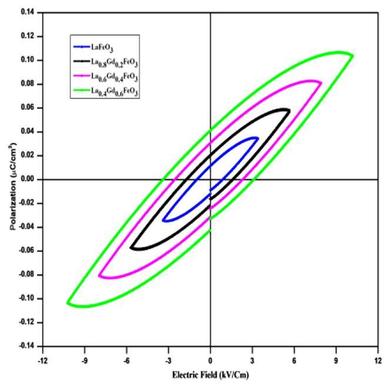
Room temperature ferroelectric loop (P-E) measured at a field of 13 kV/cm.